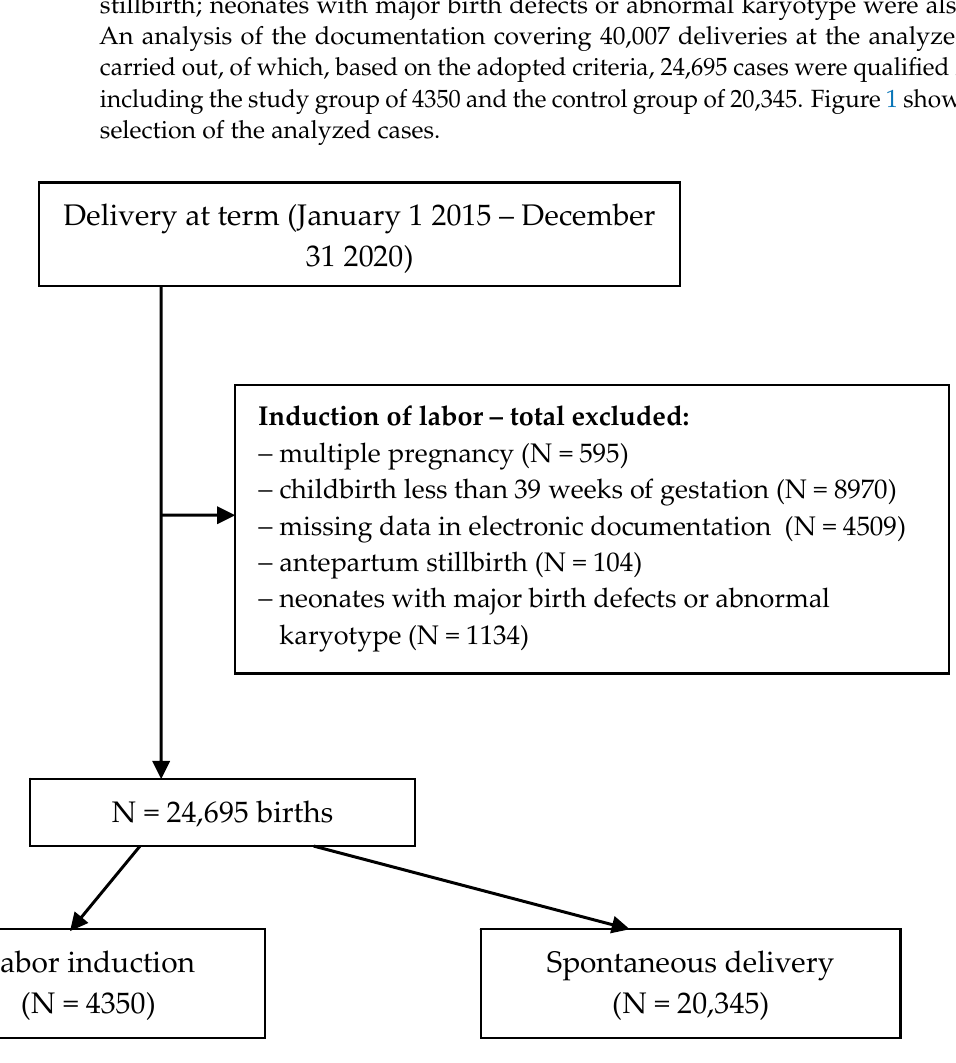
Figure 1. Flow diagram of exclusions and final analytic sample.